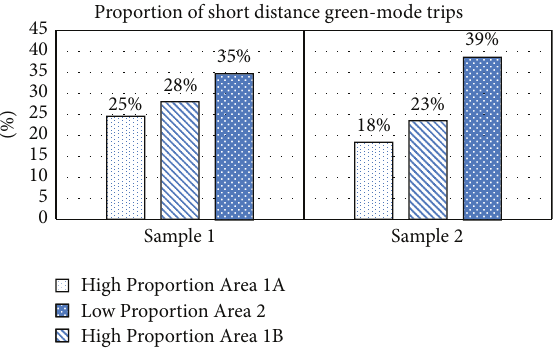
Figure 6: Proportion of short distance green-mode trips.